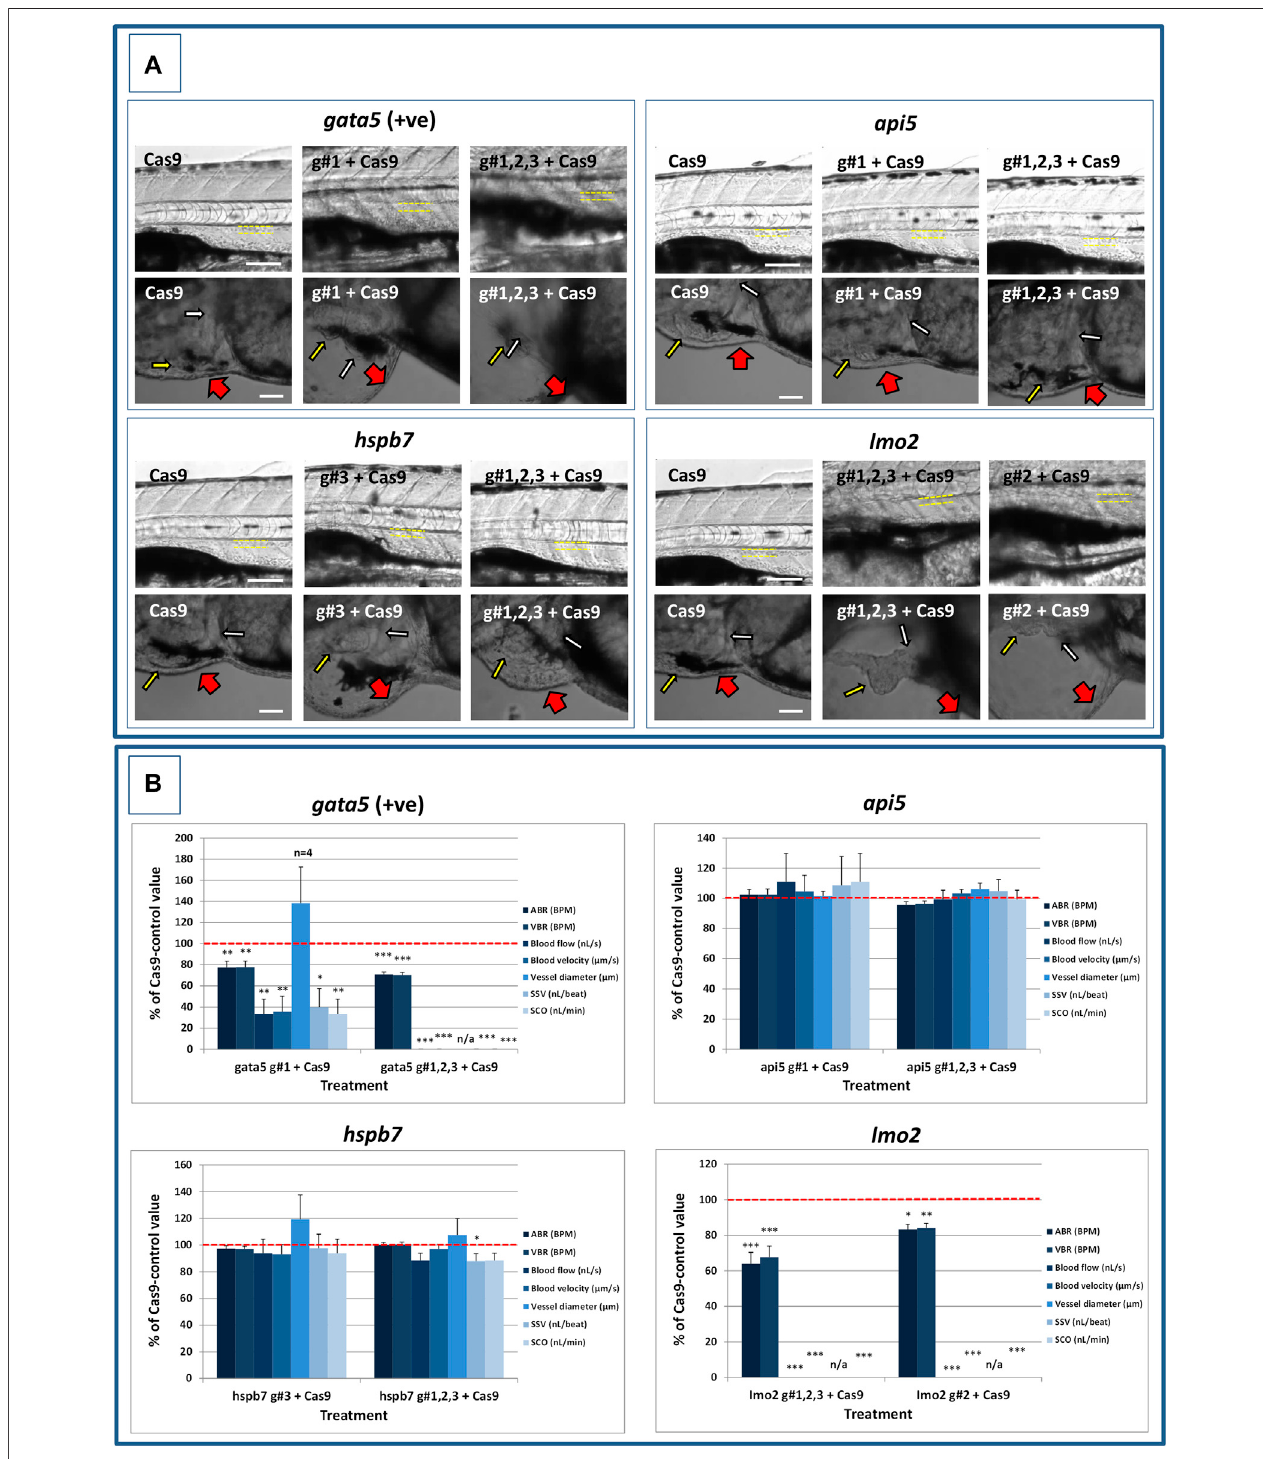
FIGURE 5 | Results of the analysis of cardiovascular function in 4 dpf gata5 (positive control), api5 , hspb7 and lmo2 zebra fi sh crispants versus the Cas9-injected control animals. (A) : Images of example Cas9 control larvae alongside larvae treated with the two gRNAs + Cas9 mixtures giving the most robust phenotypes (as assessedat2dpf).Imagesareshownfor gata5 crispantsinthetopleft;for api5 inthetopright;for hspb7 inthebottomleft;andfor lmo2 inthebottomright.Ineachcase the top row shows the trunk vasculature with the position of the dorsal aorta outlined in yellow dashed lines, where blood fl ow and vessel diameter measurements weretaken.Thelowerrowofimagesshowstheheartfromthesameanimals,withtheatriumhighlightedbyasmallwhitearrow,andtheventriclebyasmallyellowarrow.